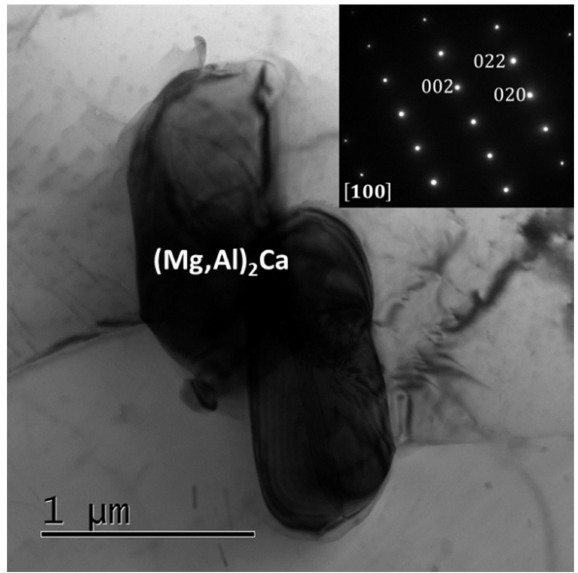
Figure 3. TEM (transmission electron microscope) bright-field micrograph of the second phase intermetallics observed in AMX601 alloy, with the corresponding electron diffraction pattern shown in the